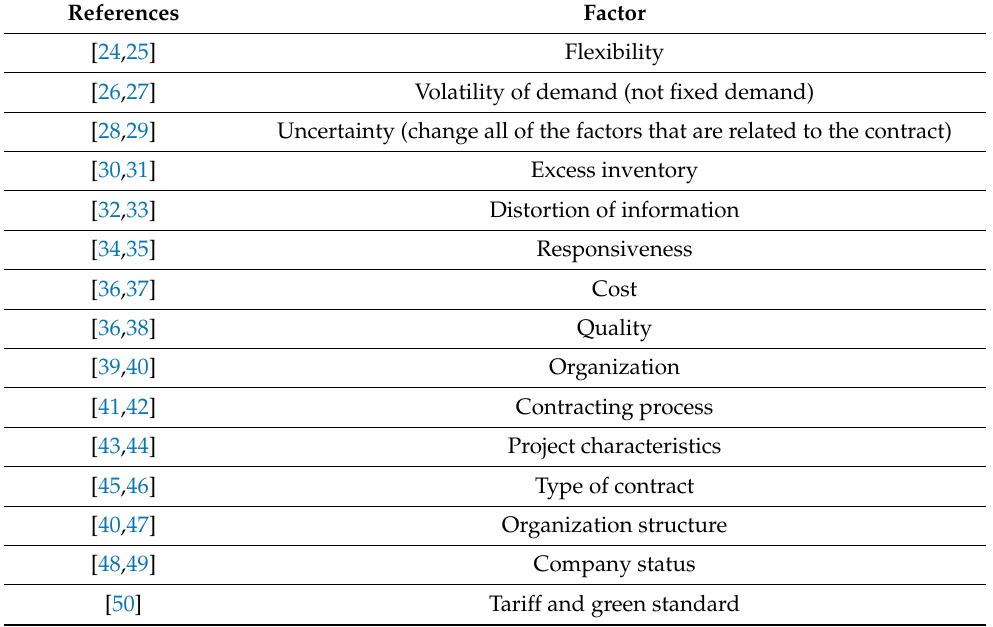
Table 1. Factors of the SCM contract selection.